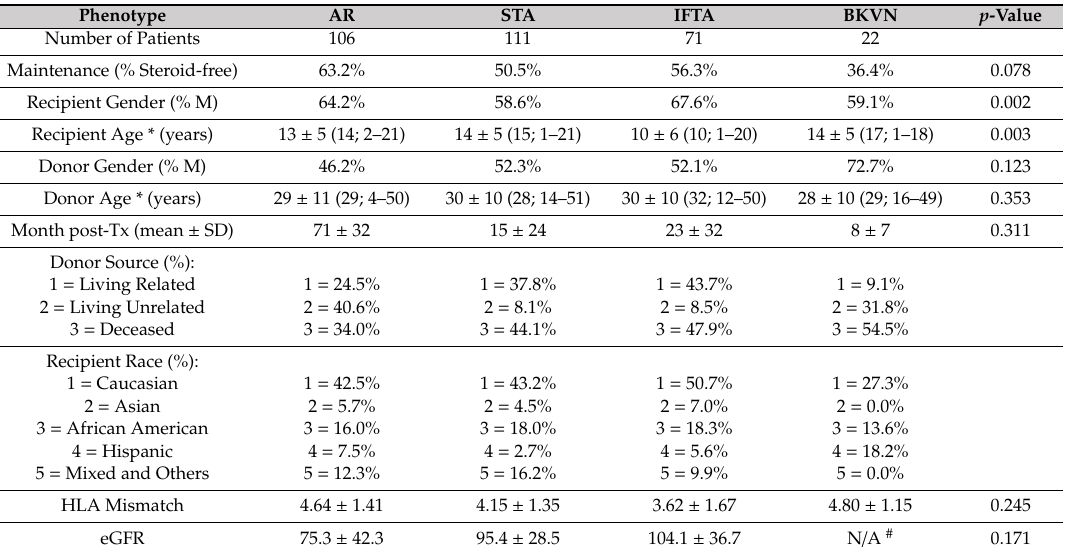
Figure 1. Sample selection and study schematic of the study. Summary outlining study samples, assay platform, study phenotypes, analysis, and results. Table 1. Patient demographic data for the discovery cohort.